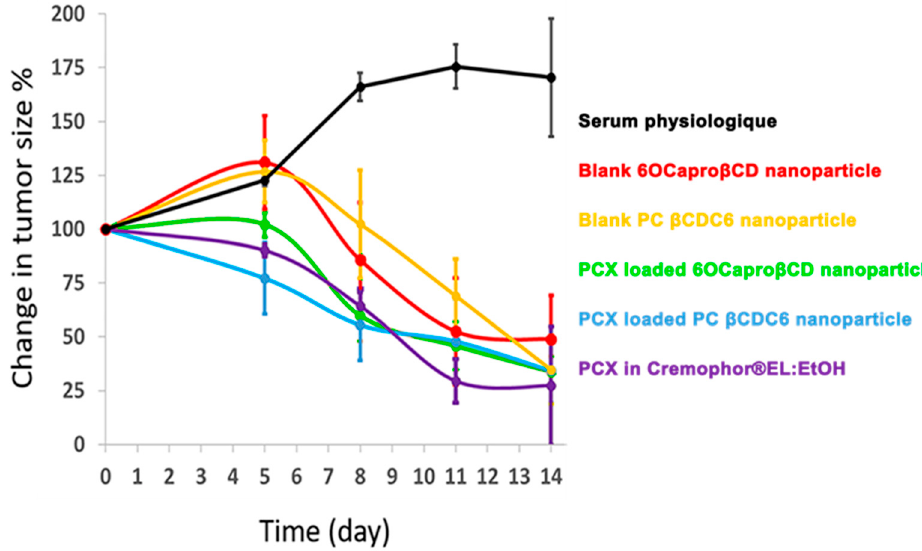
Figure 8. Change in the tumor size upon treatment with blank, paclitaxel-loaded cyclodextrin nanoparticles, and paclitaxel solution in Cremophor ® EL:EtOH. Data were represented as mean ± SD.